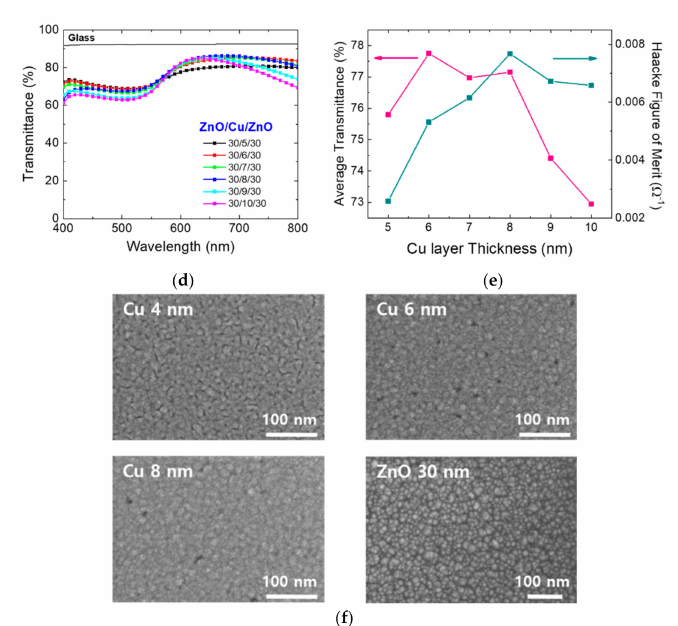
Figure 1. ( a ) Schematic structure of ZnO / Cu / ZnO electrodes. ( b ) A cross-sectional TEM micrograph for ZnO (20 nm) / Cu (8 nm) / ZnO (40 nm). ( c ) Sheet resistance of the electrodes as a function of Cu layer thickness. The top and bottom ZnO layers are both fixed at 30 nm. ( d ) The transmittance of the ZnO / Cu / ZnO electrodes as a function of Cu layer thickness with the top and bottom ZnO thicknesses both kept at 30 nm. The air baseline was taken and the transmittance of bare glass is also given as reference. The air baseline was taken. ( e ) The average visible light transmittance and the Haacke figure of merit values (evaluated with the average visible light transmittance) are plotted together. The highest Haacke figure of merit is obtained with the Cu layer thickness of 8 nm. ( f ) SEM micrographs showing the morphologies of Cu layers having thicknesses of 4, 6 and 8 nm, respectively, for which the top ZnO layer was not deposited for direct observation of the Cu layers. An SEM image of the top ZnO layer for the ZnO (30 nm) / Cu (8 nm) / ZnO (30 nm) electrode was also shown.